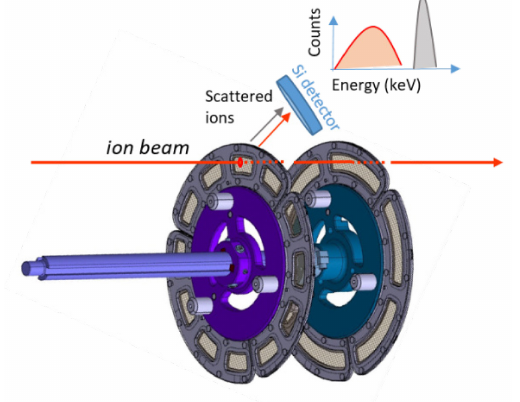
Fig. 4. Principle of the Rutherford scattering method to monitor targets’